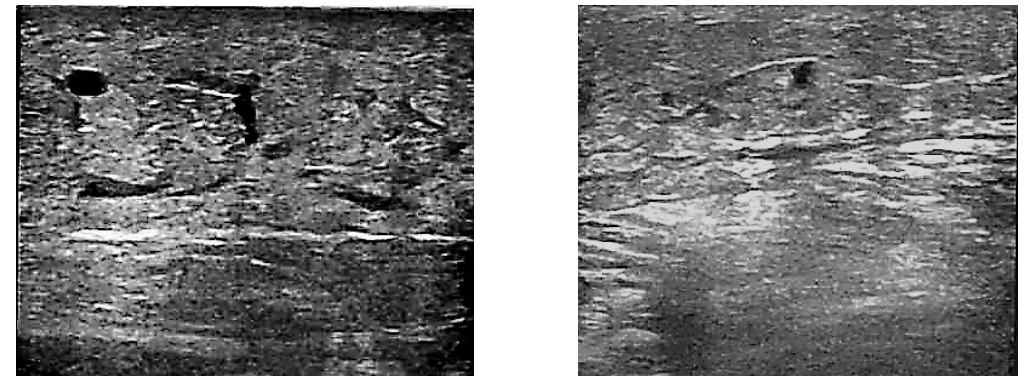
Figure 1. Ultrasound images of the perivascular space in a patient before ( a ) and after ( b ) 3 months of diosmin treatment .